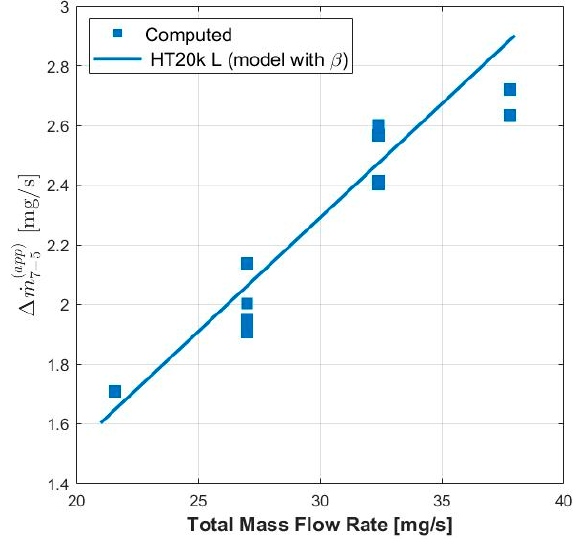
. ( app ) m 7 − 5 calculated from